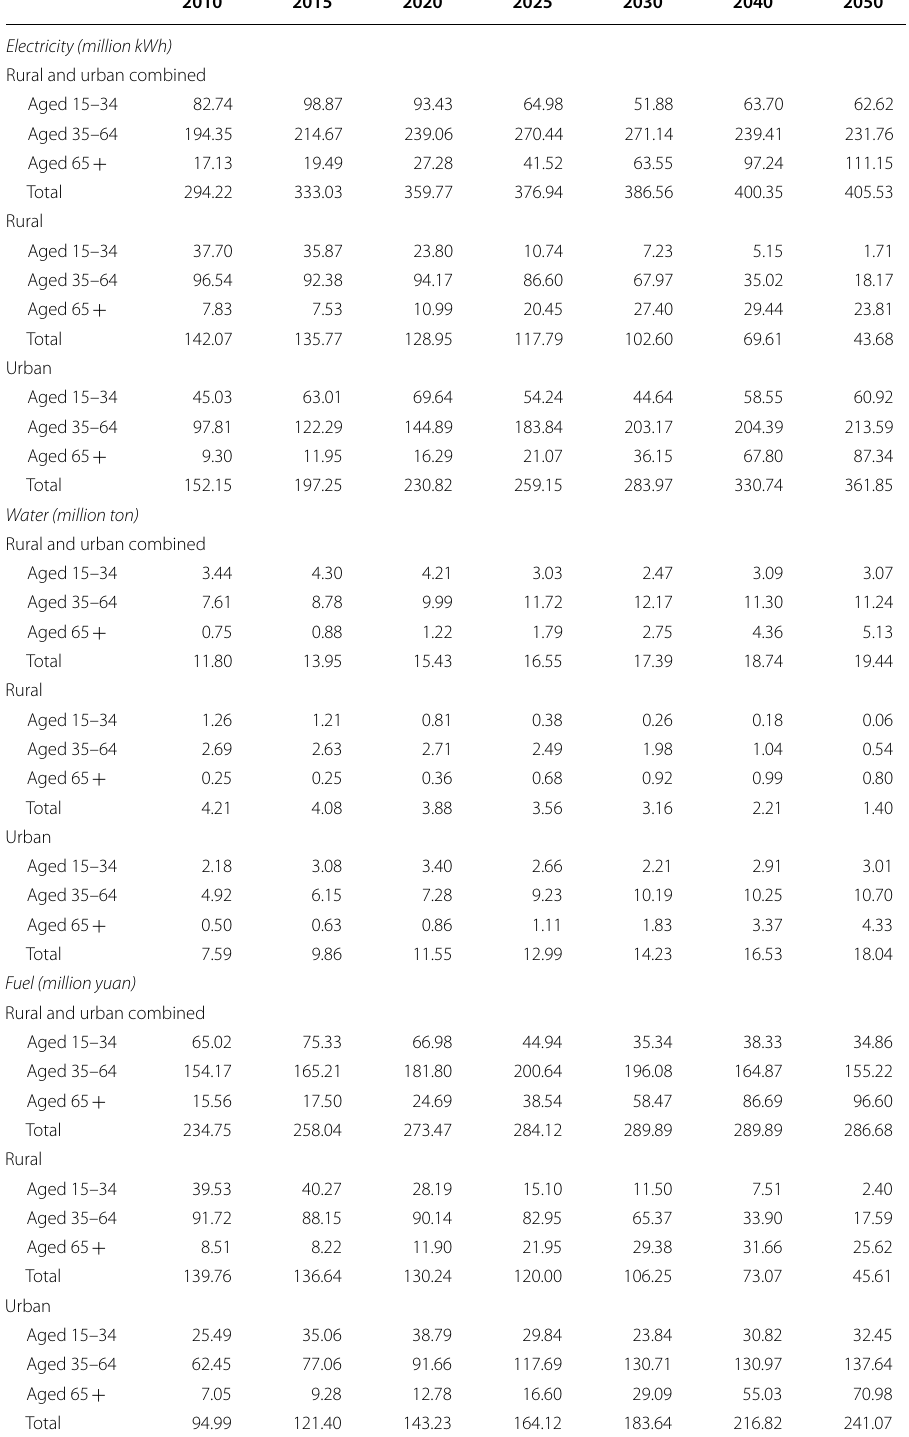
Table 4 Residential energy demands by types of energy, rural/urban and ages of householders, Hebei province, China,